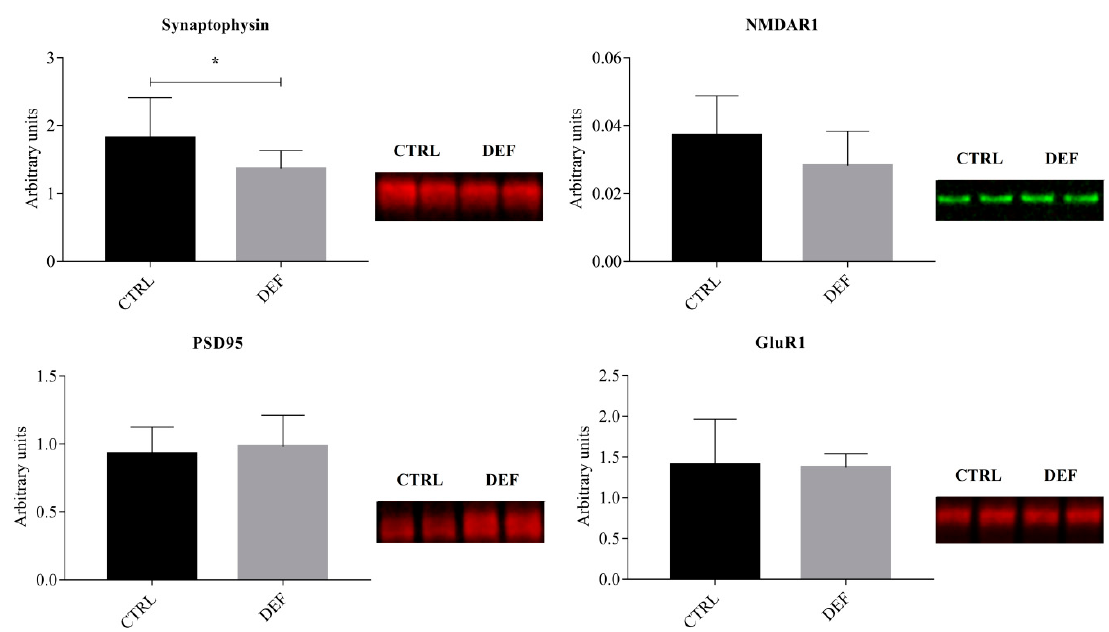
Figure 3. Synapse markers in the hippocampus. The figure shows the results from the Western blotting of markers of synapse formation. Synaptophysin is down-regulated in the DEF group ( p = 0.0160), while N -methyl- D -aspartate receptor 1 (NMDAR1) displays a tendency for down-regulation ( p = 0.0525). Data is displayed as mean ± SD and analyzed by Student’s or Welch’s t -test. *: p < 0.05; PSD-95: Post-synaptic-density-protein-95; CTRL: Control animals ( n = 13); DEF: Deficient animals ( n = 12); GluR1: α -amino-3-hydroxy-5-methyl-4-isoxazolepropionic acid receptor subunit 1.